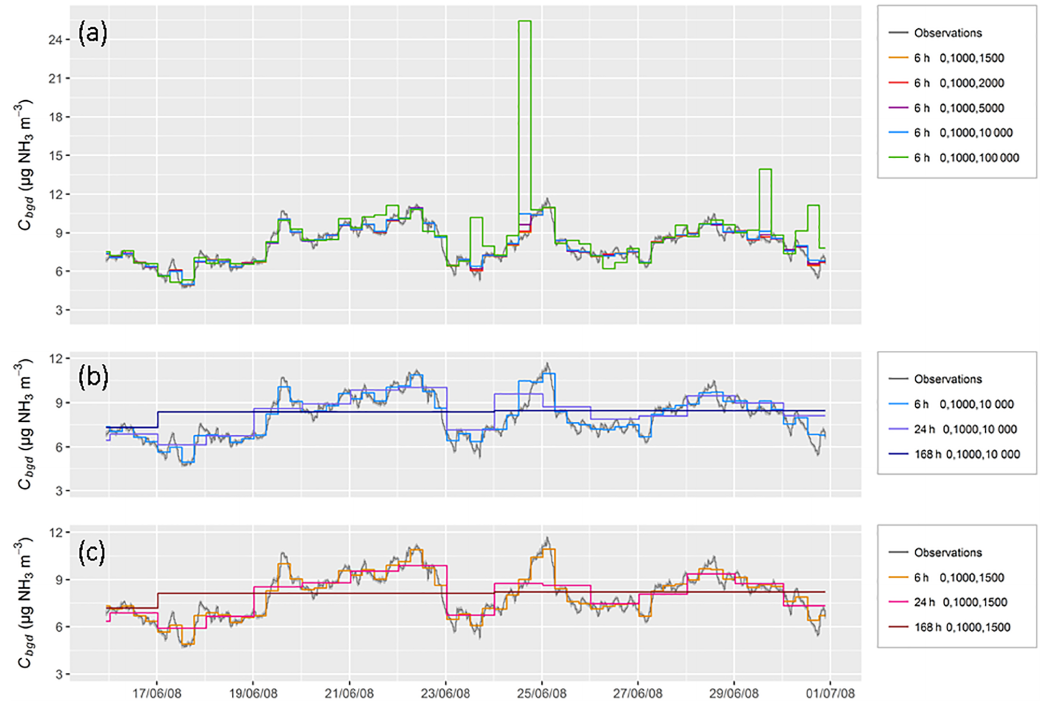
Figure 13. Background concentrations prescribed (Observation) and inferred using strategy C7 and height combination (0.25, 2m): (a) effect of the treatment contrasts for a short integration period of 6h (treatments 1, 2 and 3 are given); (b) effect of integration period for contrasted treatments ( (cid:48) = 0, 1000, 10000); (c) effect of integration period for similar treatments ( (cid:48) = 0, 1000,